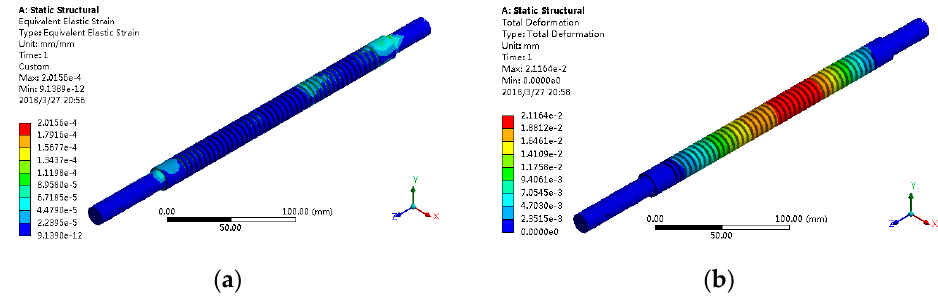
Figure 10. Finite element analysis results of fixed support at both ends: ( a ) equivalent elastic strain and ( b ) total deformation.